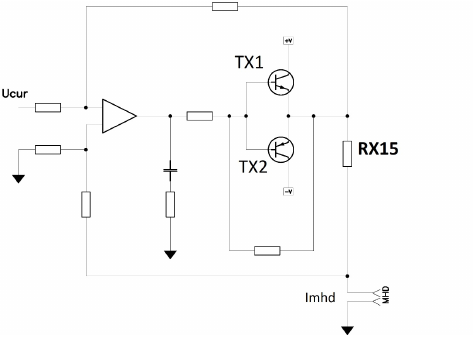
Figure 3. Scheme is electric current generator circuit with transistors TX1 and TX2 through the MHD cell. MHD are output pins for MHD